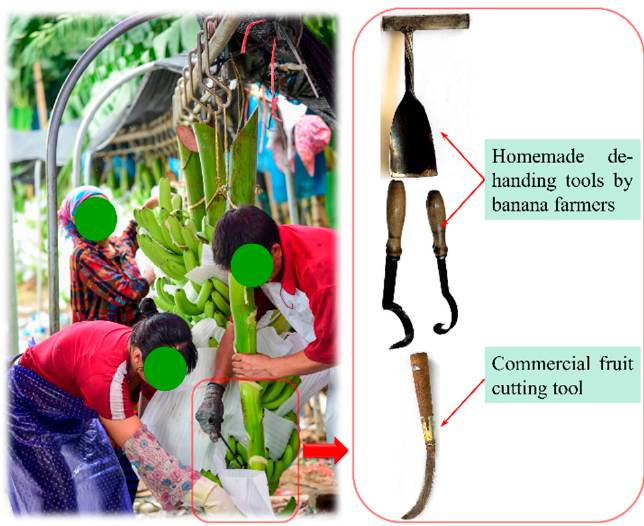
Figure 3. Manual de ‐ handing mode of banana bunches using a simple cutting tool. Figure 3. Manual de-handing mode of banana bunches using a simple cutting